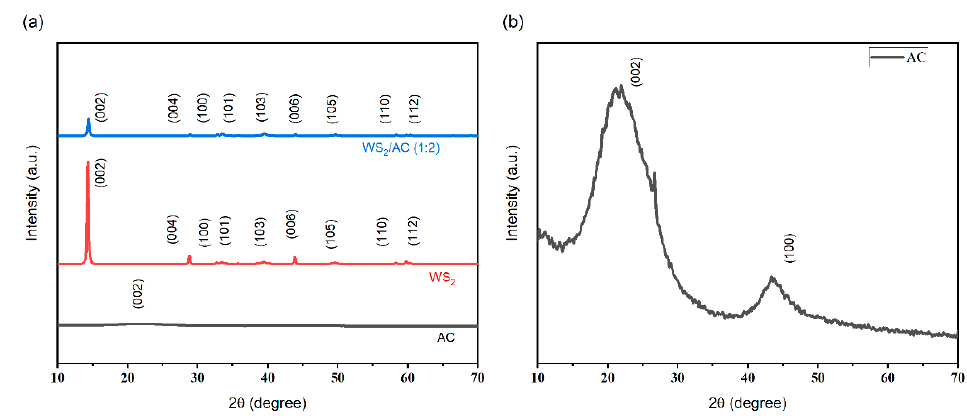
Figure 2. XRD patterns of ( a ) the synthesized WS 2 , AC, and WS 2 /AC (1:2) counter electrodes used in DSSC and ( b ) pure activated carbon.